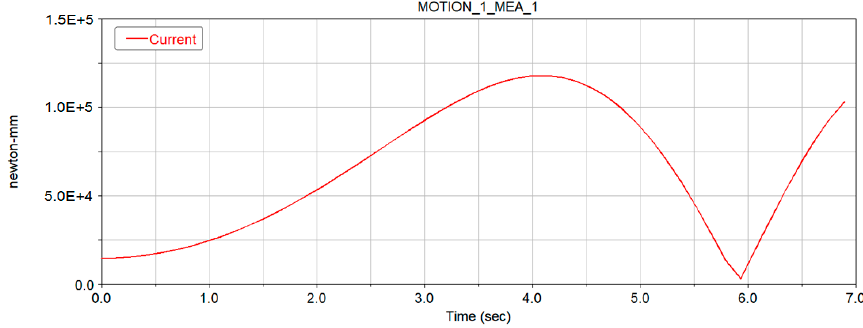
Figure 7. 3D model imported in MSC Adams